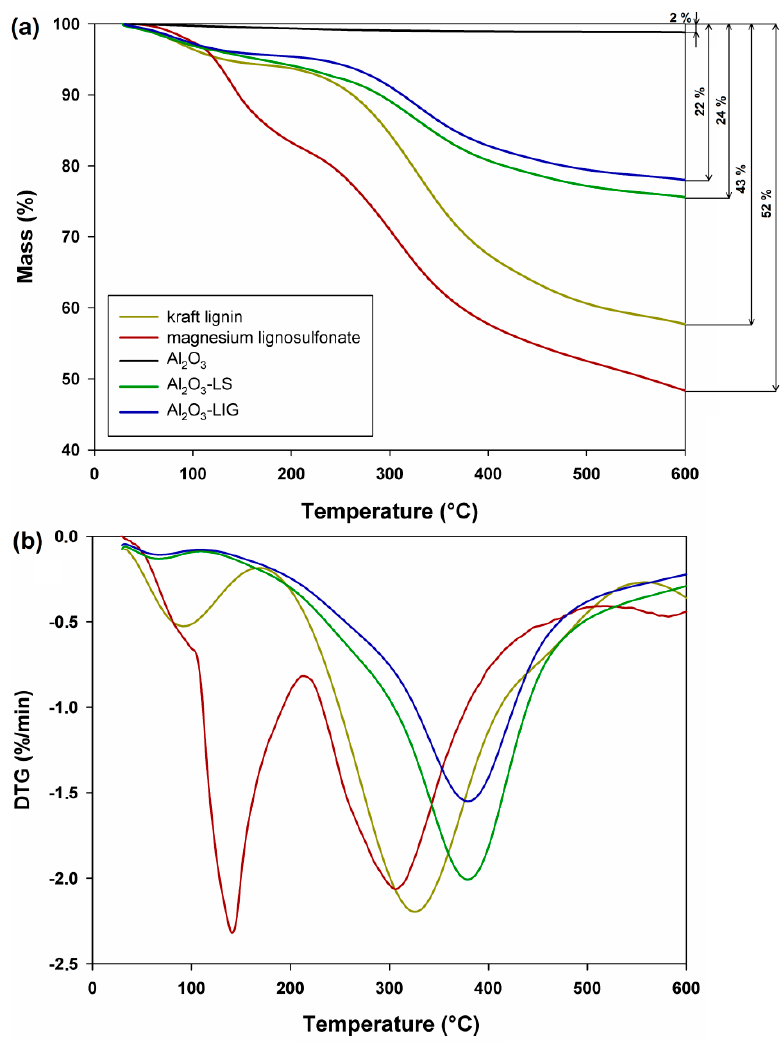
Thermogravimetric (TGA) ( a ) and DTG ( b ) curves of original components and inorganic-organic hybrid materials.